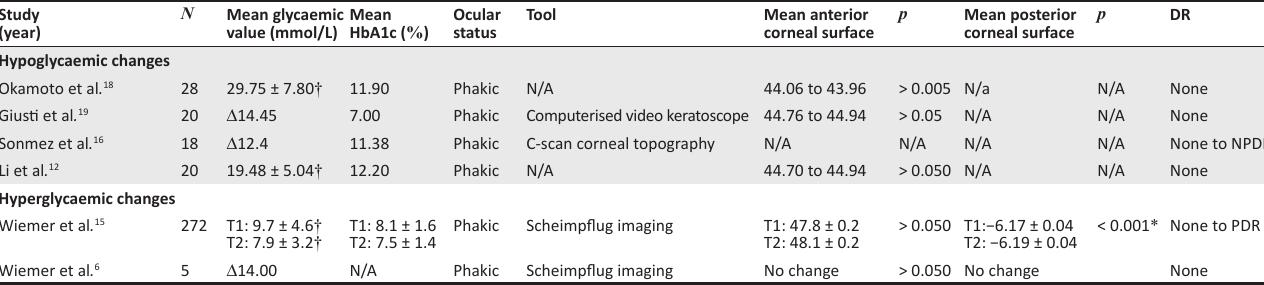
TABLE 2: Effect of glycaemic changes on corneal curvature in people living with Diabetes Mellitus. N Tool Mean anterior Study (year)